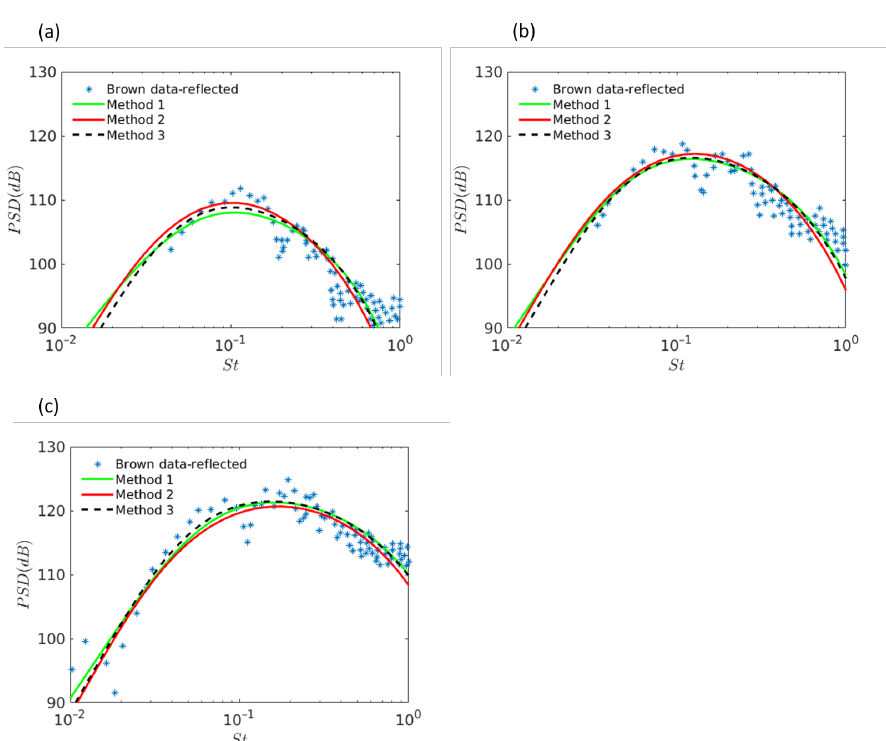
Figure 13. Comparison of the acoustic predictions for methods 1, 2 and 3 using MP-AIDEA ( a ) Ma = 0.5 ( b ) Ma = 0.7 ( c ) Ma = 0.9.